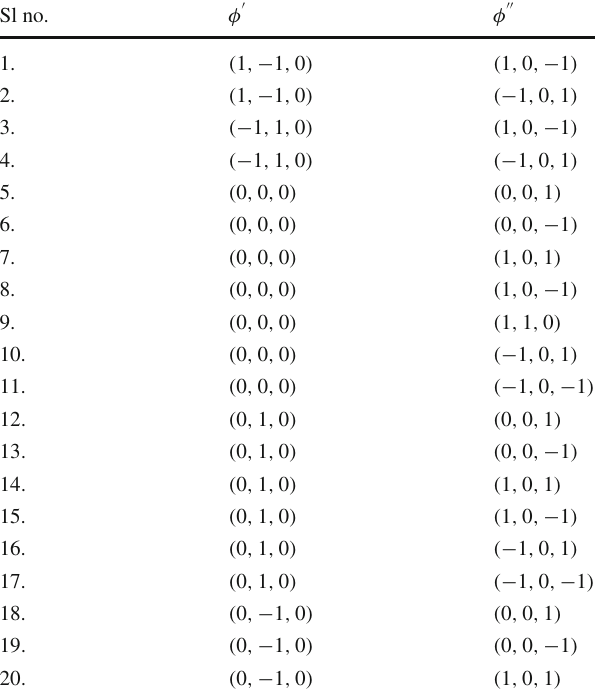
Table 17 Texture zero in the entire 3rd row and column of 4 × 4 matrix Sl